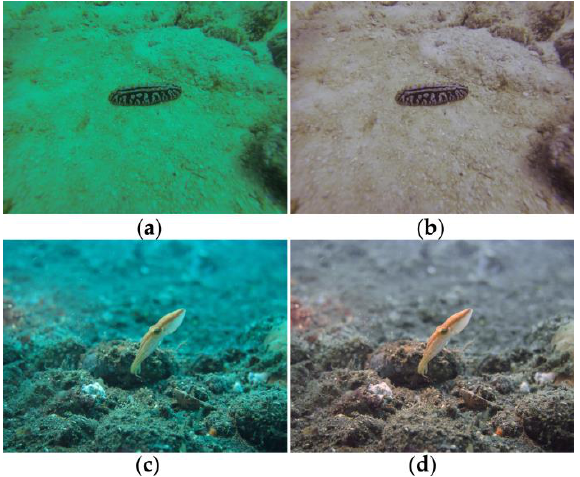
Figure 1. Color cast and restoration of underwater images: ( a ) and ( c ) show the raw images, ( b ) and ( d ) present the restored results obtained by the proposed method. Raw images are provided with the UIEB dataset [8].